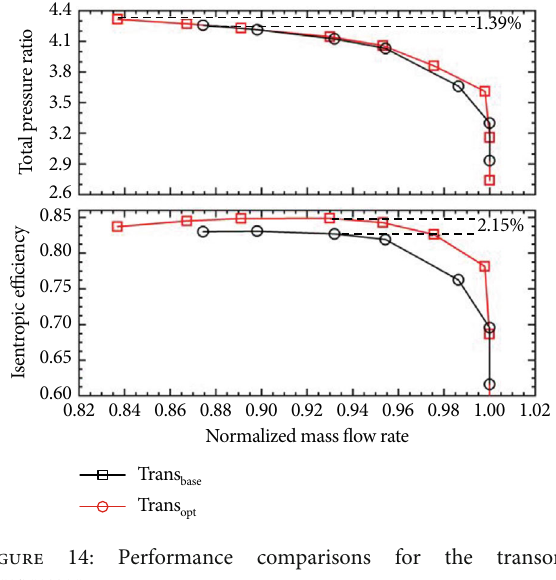
Figure 14: Performance comparisons for the transonic